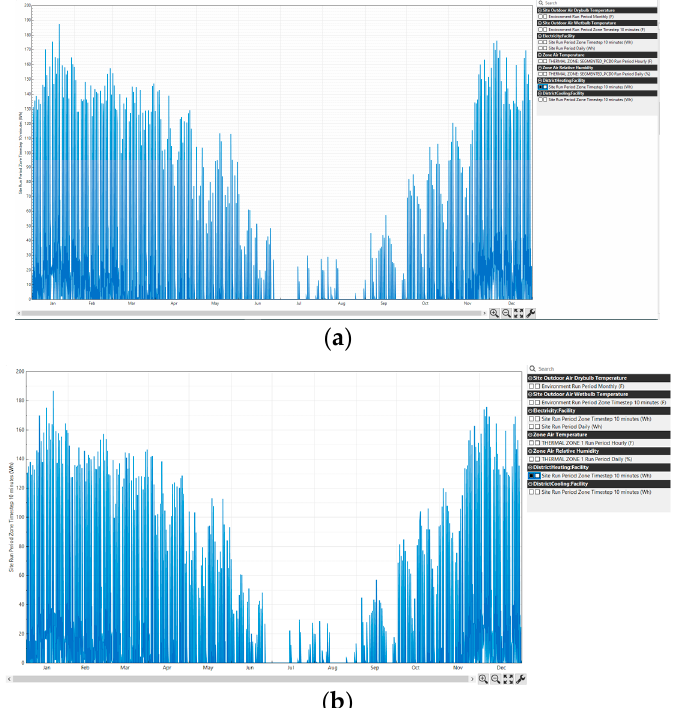
Figure 22. Comparison between heating consumption along a year for scenario 1: ( a ) Estimated model; ( b ) Manually generated model.